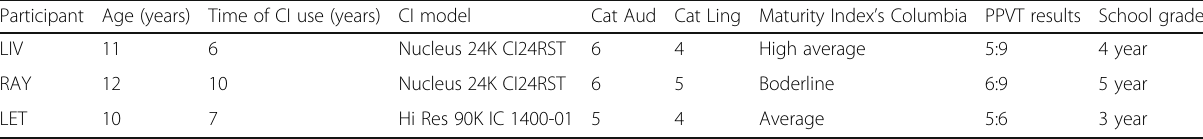
Table 1 Characterization of participants by age, time of CI use, CI model, hearing categories (CatAud), language categories (CatLing), maturity index ’ s Columbia (considering level appropriate for chronological age), result ’ s PPVT (Peabody Picture Vocabulary Test-IV)